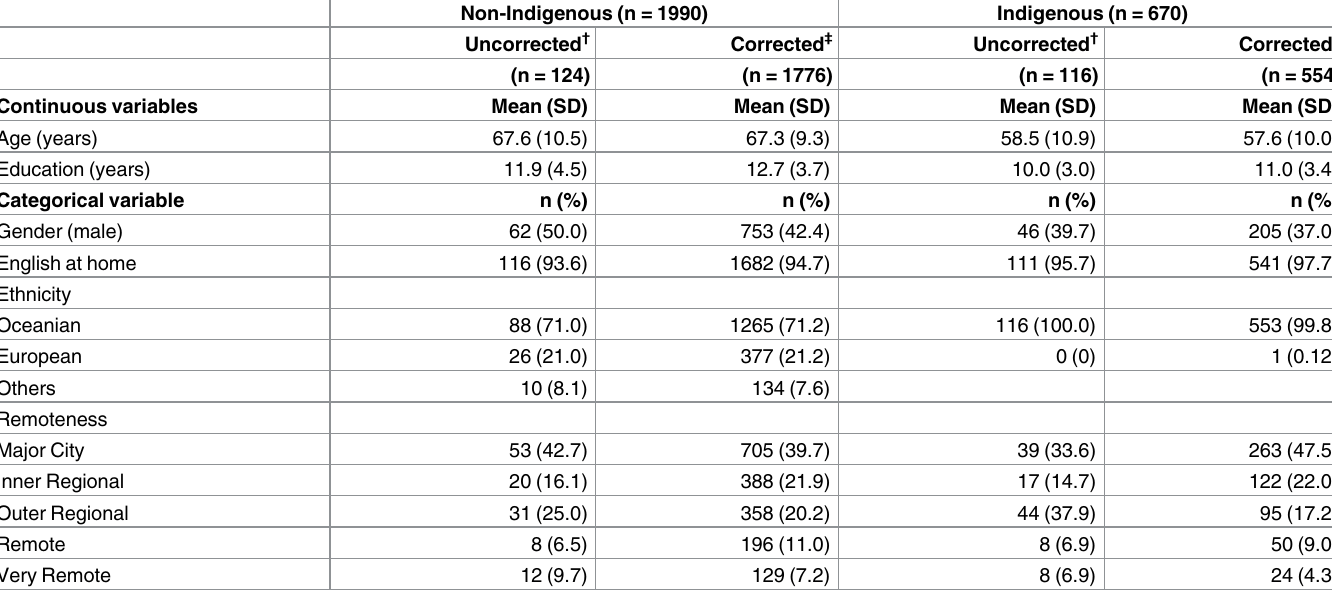
Table 1. Demographic characteristics of participants with correctedrefractiveerror and participants with uncorrected or under-corrected refrac- tive error Non-Indigenous (n = 1990) Indigenous (n =